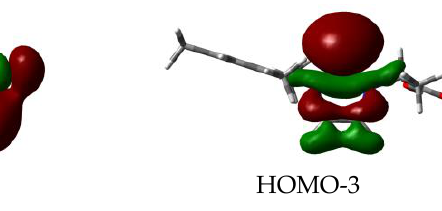
Figure 4. Selected MOs of [NHC Mes,H ] − ligand.